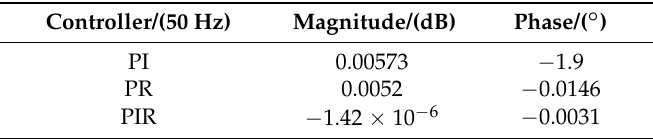
Table 2. Comparison of errors